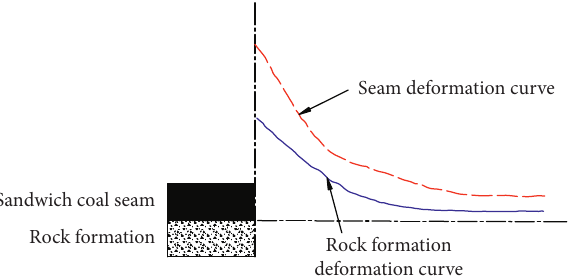
Figure 10: Comparison of deformation distribution of surrounding media in surrounding rock of coal-rock interbed